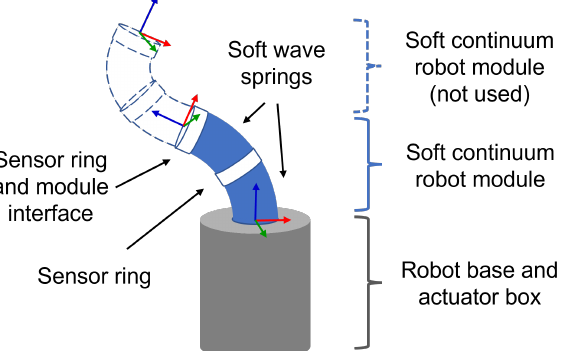
Figure 1. Depiction of the soft continuum robot. Arrows in green, red and blue represent base and tip axis x, y and z of each module